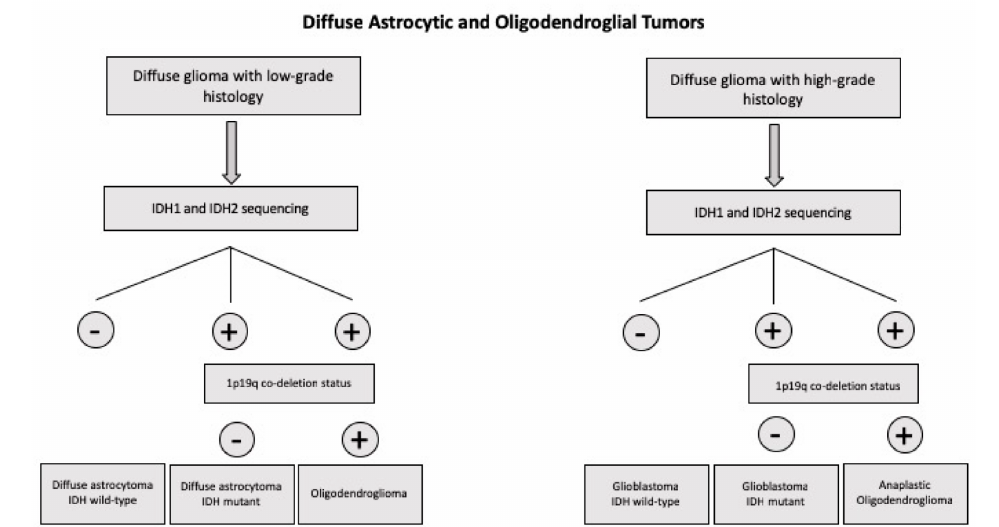
Figure 6. Subdivision of diffuse astrocytic and oligodendroglial tumors into various subgroups according to few diagnostic criteria, mainly represented by IDH1 / IDH2 mutations and some chromosome abnormalities (1p and 19q